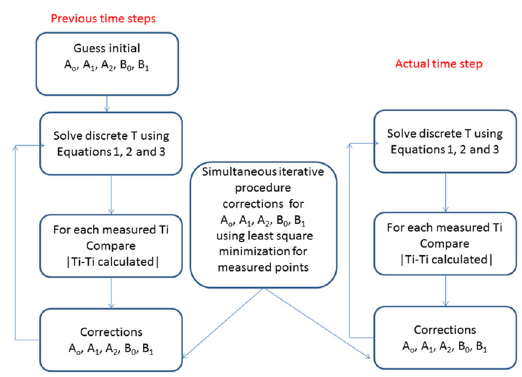
Figure 3. Flowchart of the iterative procedure to estimate the constant parameters for equations 2 and 3 based on discrete measurements of transient Table 1. Selected double ellipsoid model parameters and welding data Voltage (V)